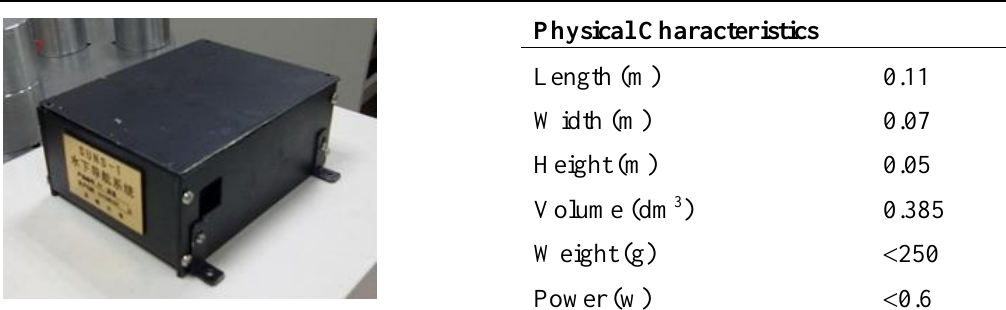
Table 3. The physical characteristics for the SUNS-2 used in this work.